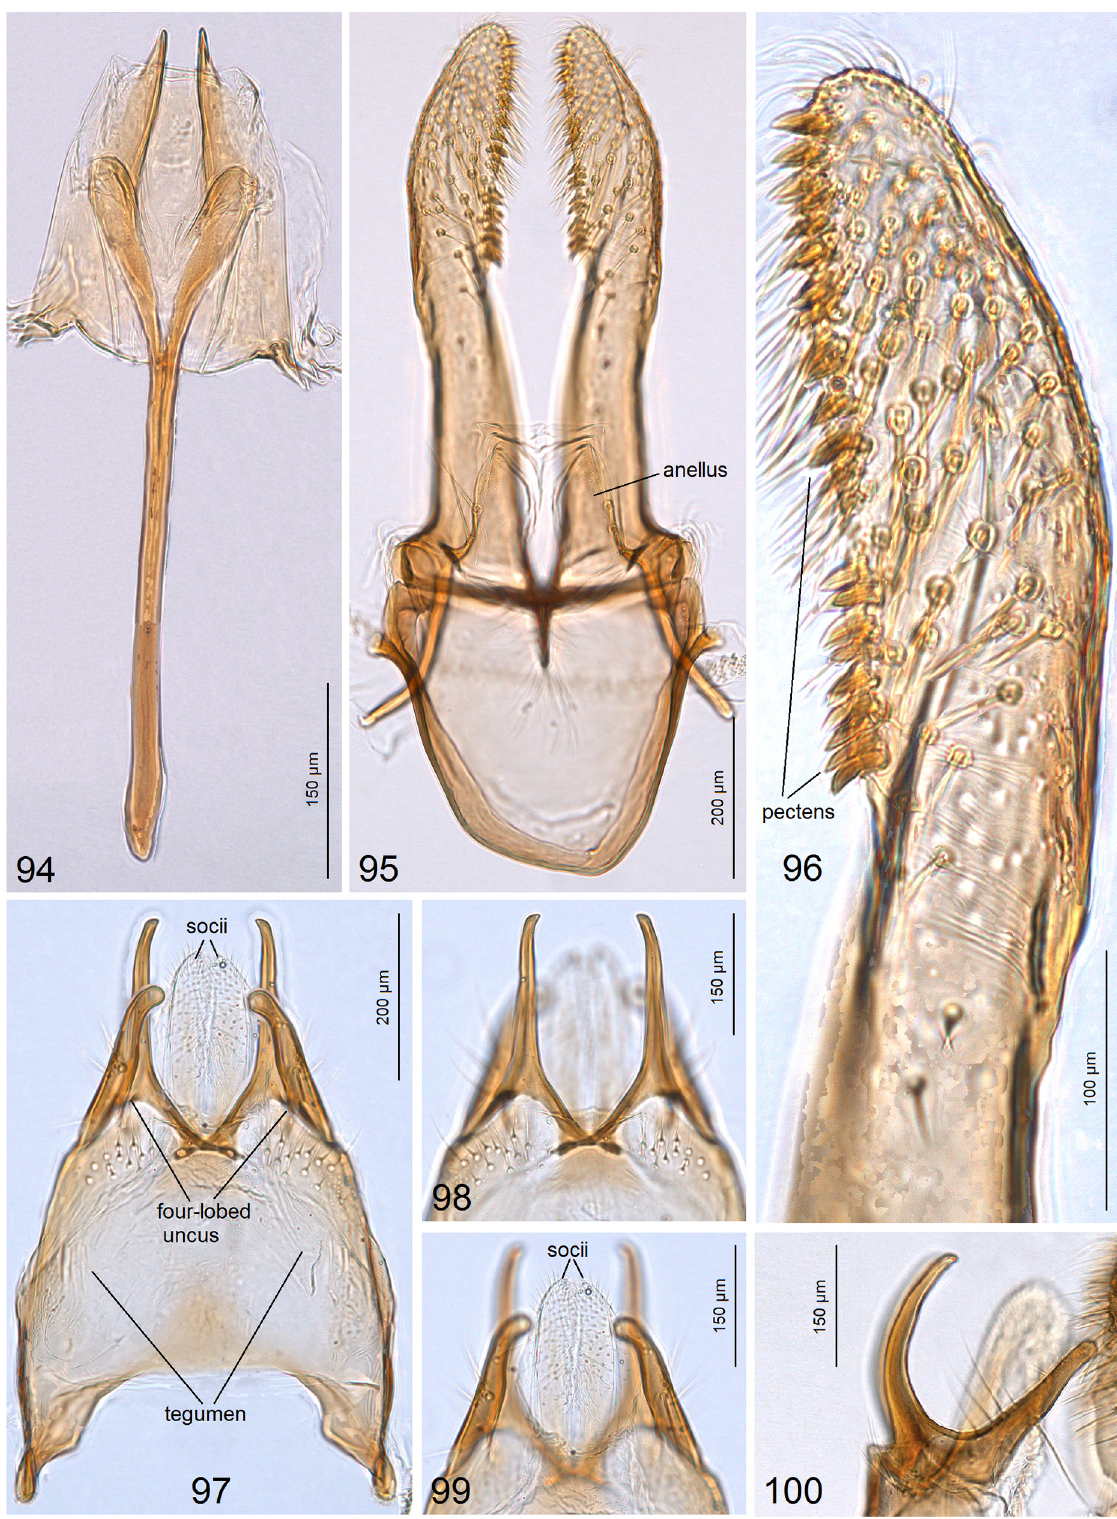
Figs 94–100. Male genitalia of Paratischeria robinsoni Diškus & Stonis sp. nov., paratype (genitalia slide no. 010316191, NHMUK). 94 . Phallus. 95 . Capsule, with uncus, temgumen and phallus removed. 96 . Apical part of valva. 97 . Uncus, socii and tegumen. 98 . Uncus, dorsal lobes. 99 . Uncus, ventral lobes and socii. 100 . Uncus, ventral lobes and socii, lateral